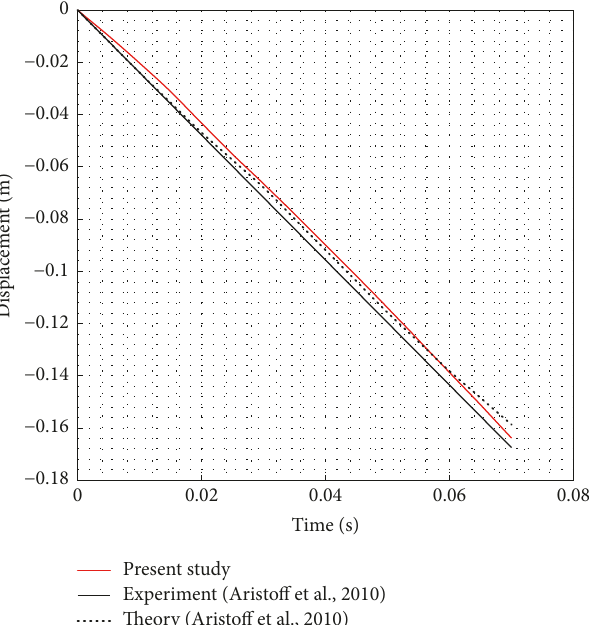
Figure 5: Comparison of displacement-time graph of sphere in water depth with the theoretical and experimental data of Aristoff et al. [10].